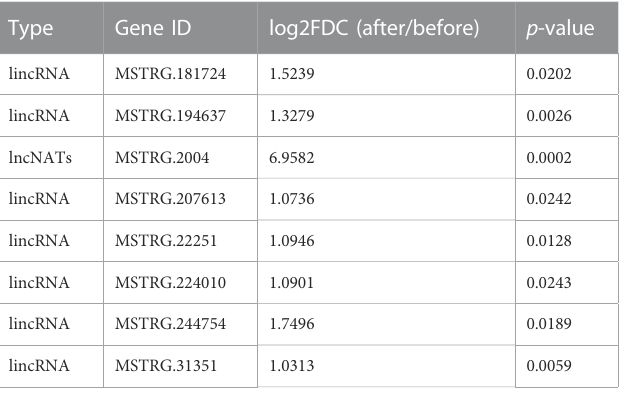
TABLE3PotentiallncRNAsinvolved innicotinebiosynthesisinMEyellowmodule and induced by